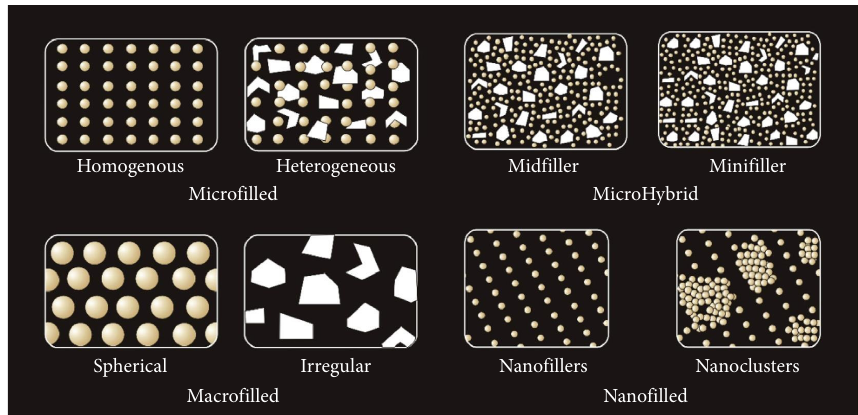
Figure 1: Classifcation of the composite on the basis of particle size and Table 1: Various brands of the smart monochromatic composites.